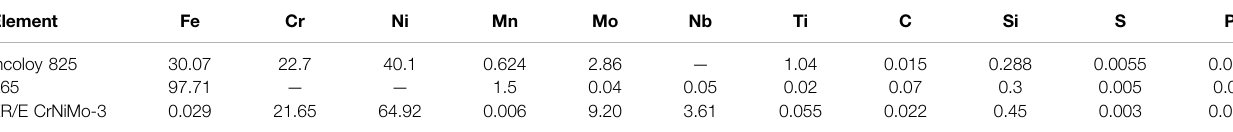
TABLE 1 | Chemical composition of X65/Incoloy 825 and fi ller metal. Element